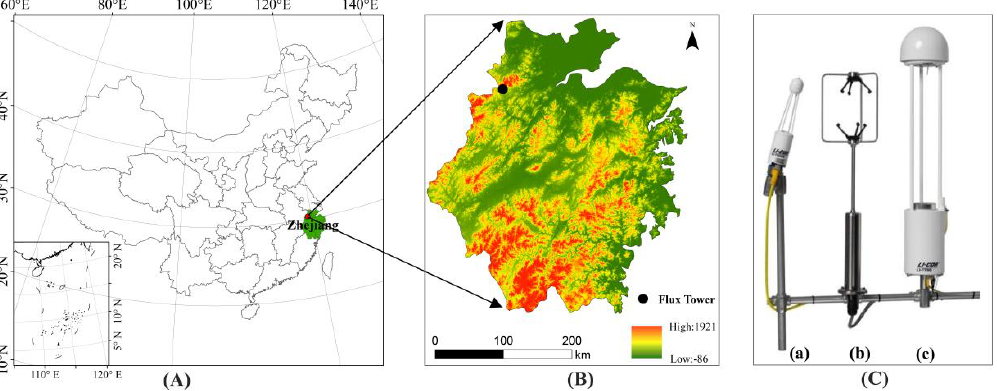
Figure 1. ( A ) Site location on a map of China. ( B ) Topography of the study region. ( C ) Eddy covariance system of the study site including (a) LI-7500A-an open-path CO 2 /H 2 O infrared gas analyzer, (b) WindMaster-a sonic anemometer and (c) LI-7700-an open-path CH 4 infrared gas analyzer.